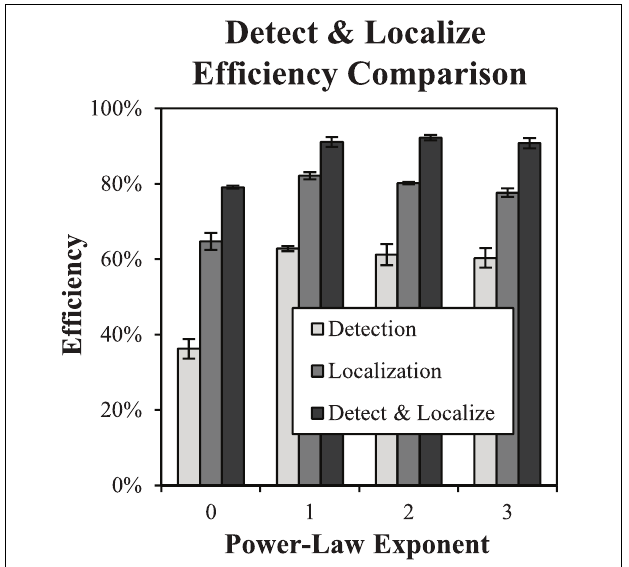
FIGURE 10 | Effect of processing the β = 0 condition. Efficiency of detection and localization tasks in β = 0 condition is plotted against efficiency with (processed) and without (unprocessed) filtering the images to have power-law spectrum with β = 2. Error bars represent ± 1 s.e. Small difference between the unprocessed data and Figures 8 , 9 are due to limiting the averages to the three subjects that participated in the processing